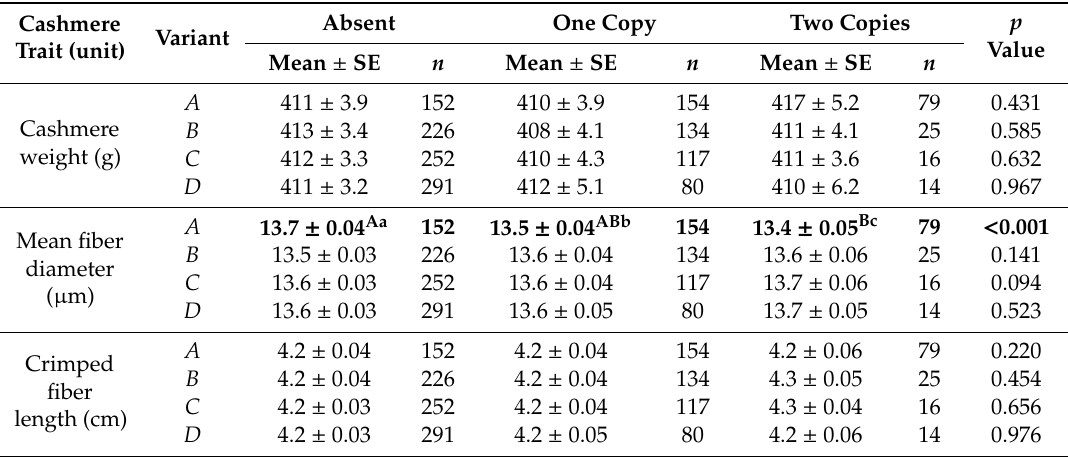
Table 2. Association of caprine KRTAP28-1 variant copy number with various cashmere traits (Mean ± SE) 1 in Longdong cashmere